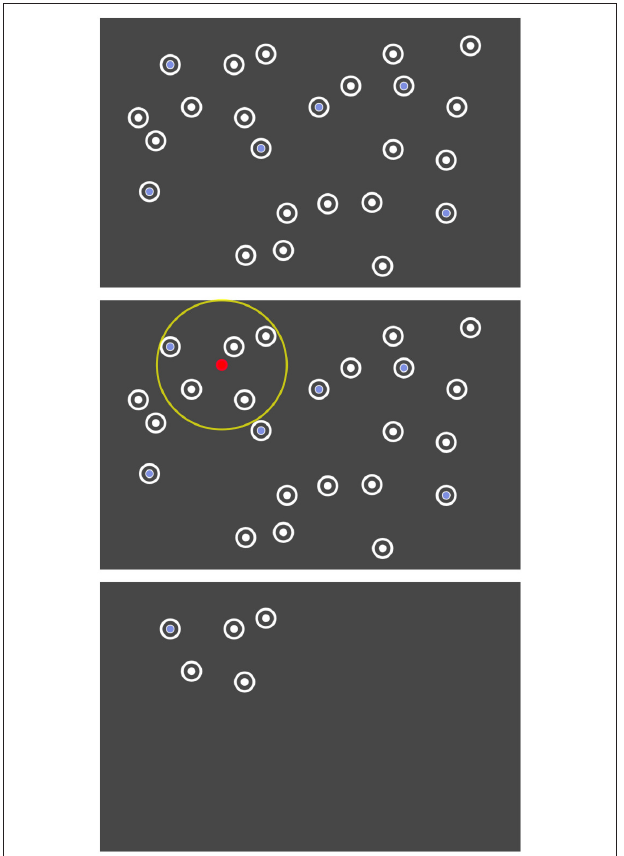
FIGURE 2 | Search task where the unrestrained gaze controlled the disclosure of the items. Top: The arrangement of the items was predefined. Center : Only items within a certain radius (yellow) around the current point-of-gaze (red) were dynamically disclosed. Bottom : Illustration of the screen at one moment in the actual